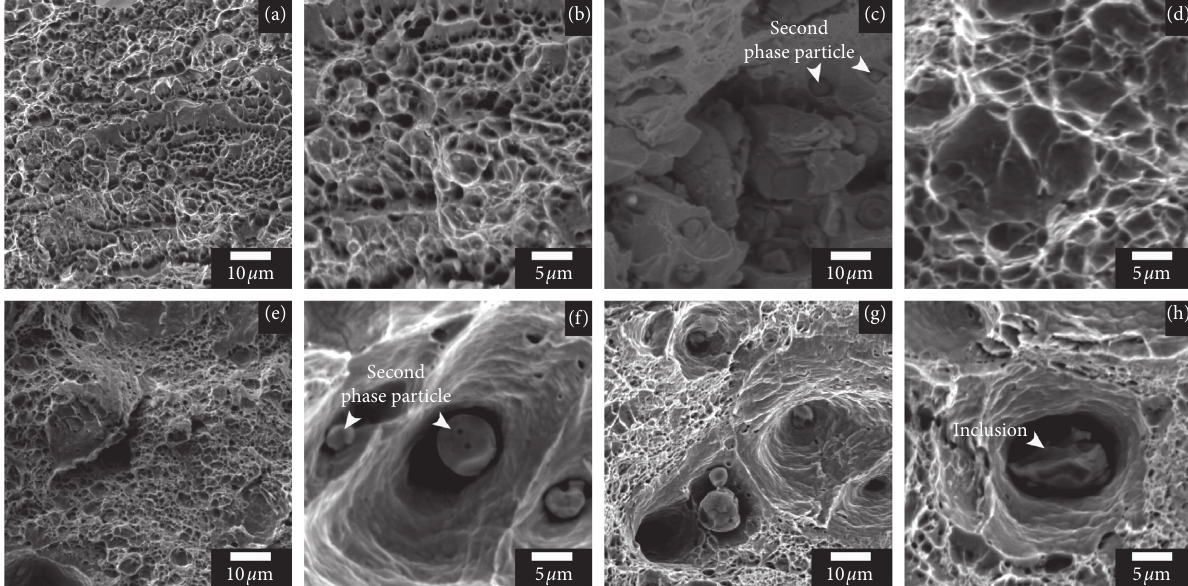
Figure 10: SEM images of the fracture surfaces from the transverse tensile samples of PWHTed CA6NM: (a, b) T1 (failed in FZ); (c, d) T2 (failed in HAZ); (e, f) T3 (failed in BM); (g, h) T4 (failed in